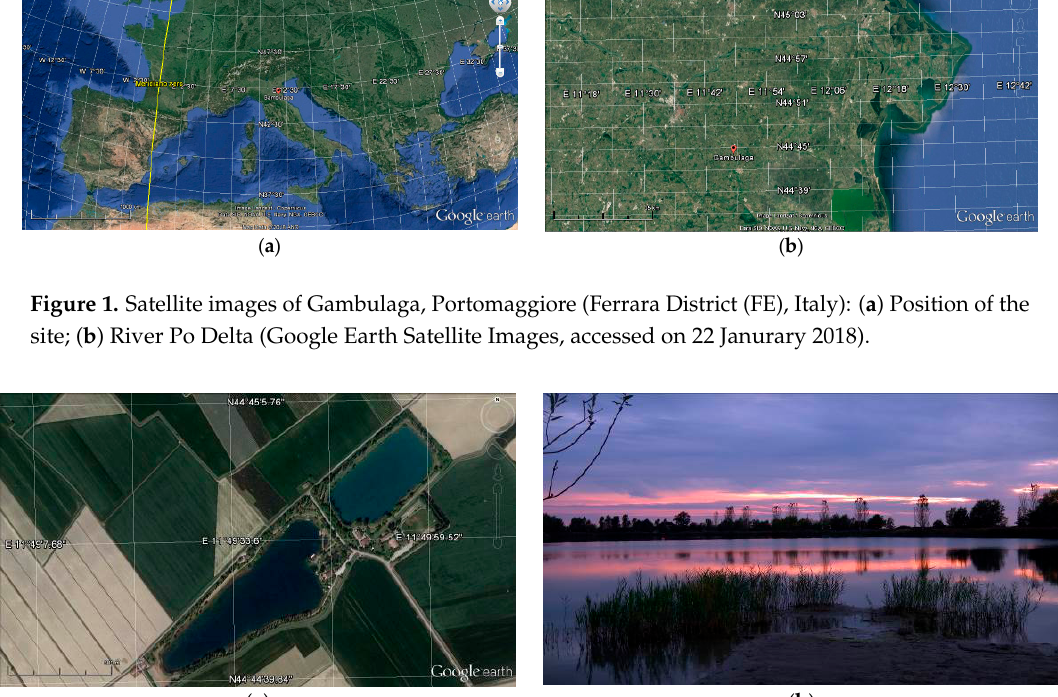
Figure 2. Satellite images of Gambulaga, Portomaggiore (FE, Italy): ( a ) Lago Tramonto and Lago Alba (Google Earth Satellite Image, accessed on 23 November 2017); ( b ) Sunset at Lago Tramonto, panorama from Northeast side.